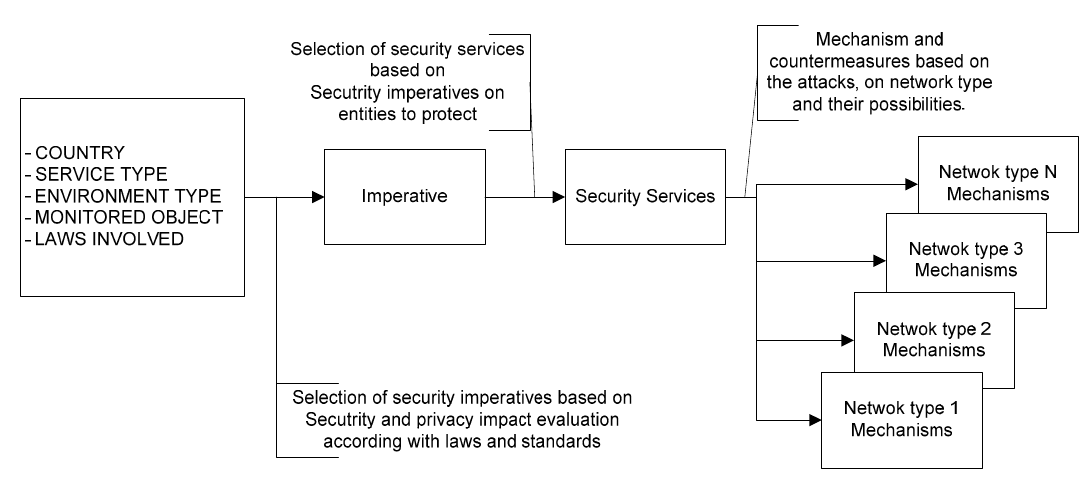
Figure 6. Selection chain of security mechanisms.